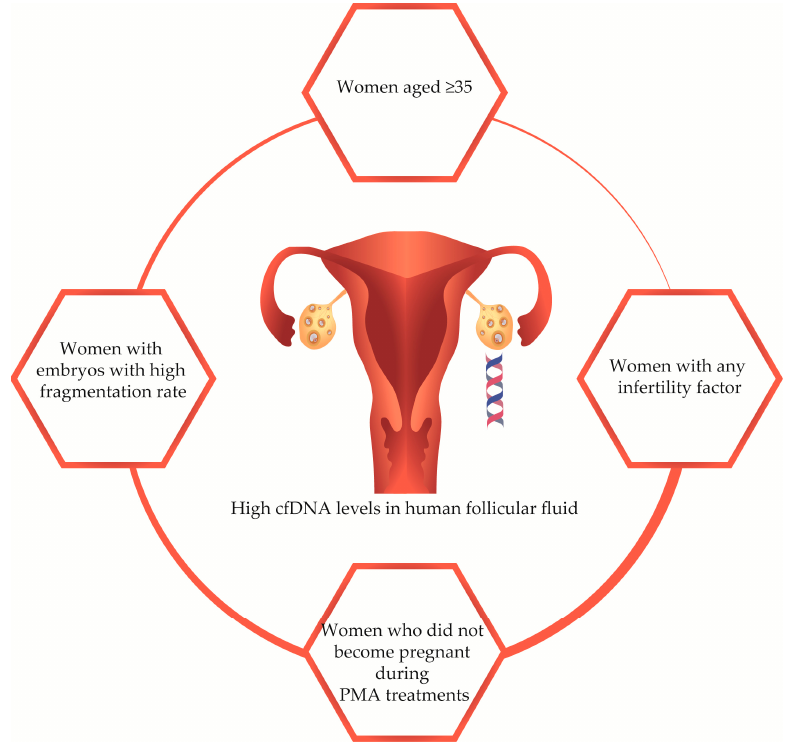
Figure 2. Schematic model of the influence of high cfDNA levels in human follicular fluid, according to our results. Age above 35 years seems to be associated with higher cfDNA concentration; in women with any female infertility factor, cfDNA levels are higher, if compared with women with no specific cause of infertility; cfDNA concentration is higher in women that obtained poor quality embryos; cfDNA levels are higher in women who had no success in pregnancy achievement after IVF treatment.